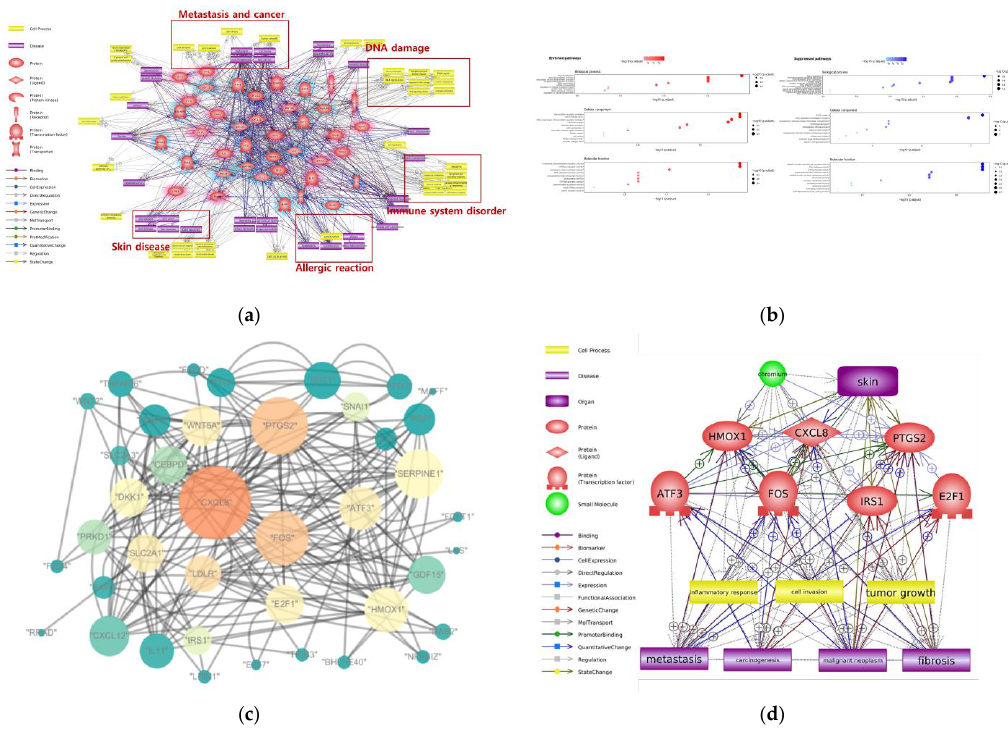
Figure 2. Bioinformatic analysis about Cr toxicity on skin. ( a ) Molecular network includes gene, cell process, diseases associated with Cr dermal contact. Potential toxicity mechanism highlighted with red color box. ( b ) Enriched and Suppressed Biological processes, Cellular components, Molecular functions associated with Cr dermal contact ( c ) Gene – gene interaction network following Cr dermal contact; each node’s color represents the betweenness centrality, each node’s size represents degree of the nodes; ( d ) Summarized molecular network and hub genes about Cr dermal contact.